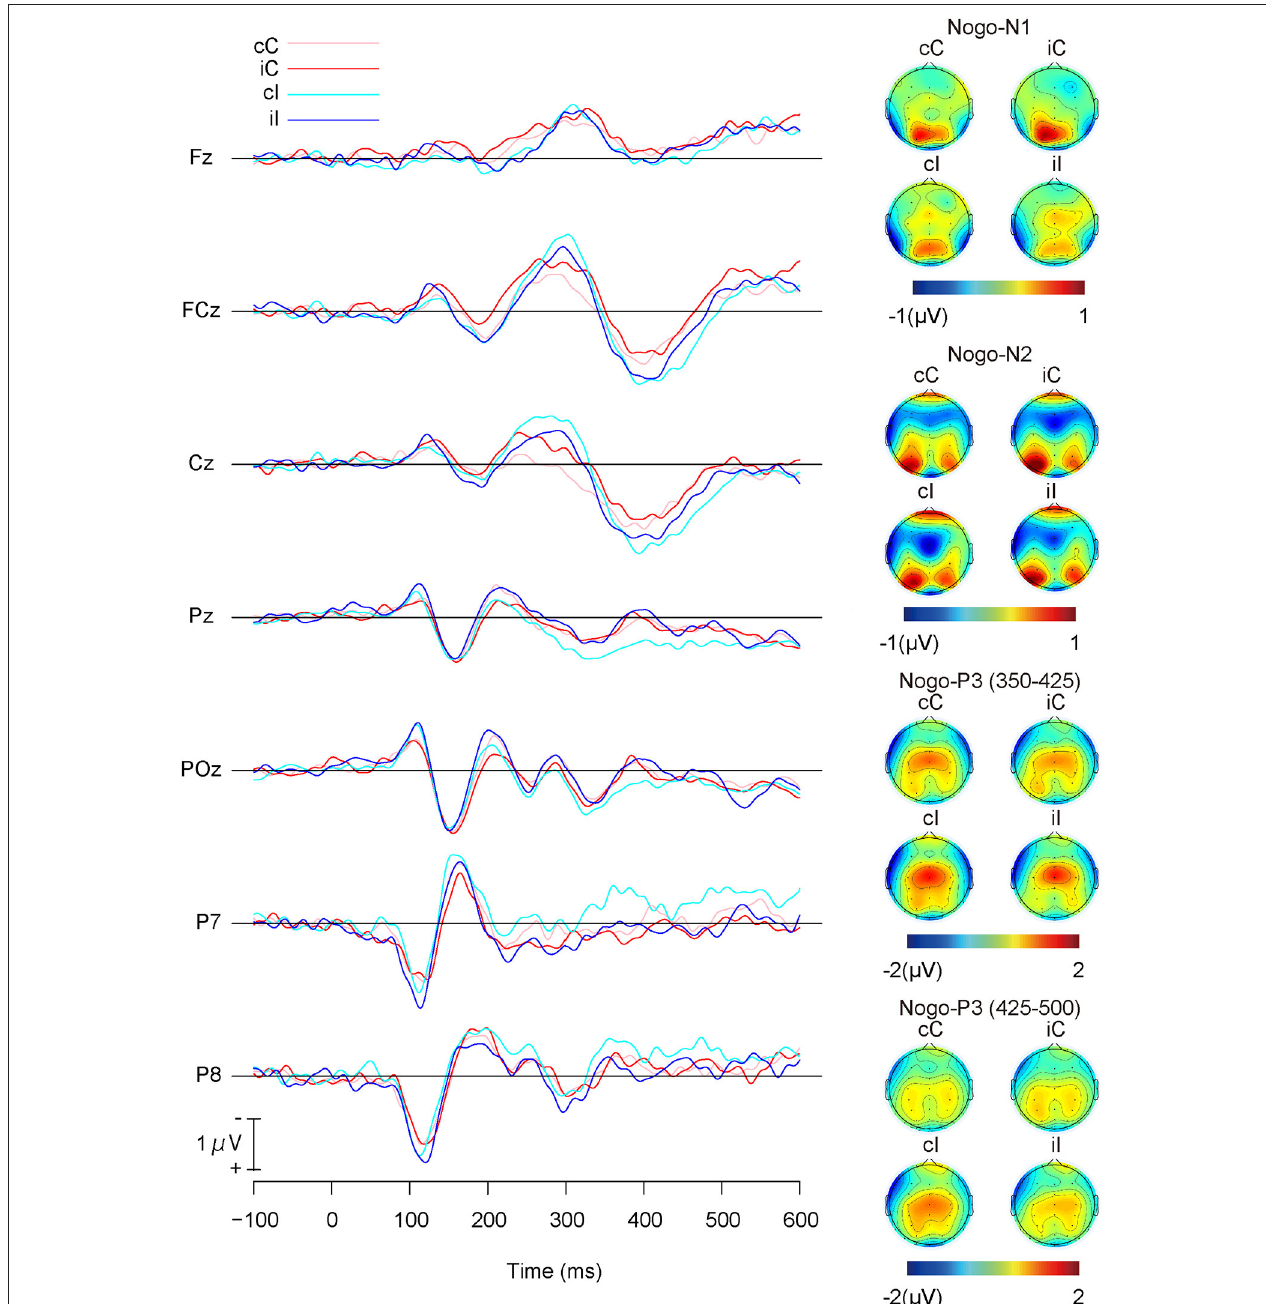
FIGURE 5 | Grand average ERP waveforms and topographies of Go-stimuli; cC: congruent (the previous trial) → Congruent (the present trial); iC: incongruent → Congruent; cI: congruent → Incongruent; iI: incongruent →